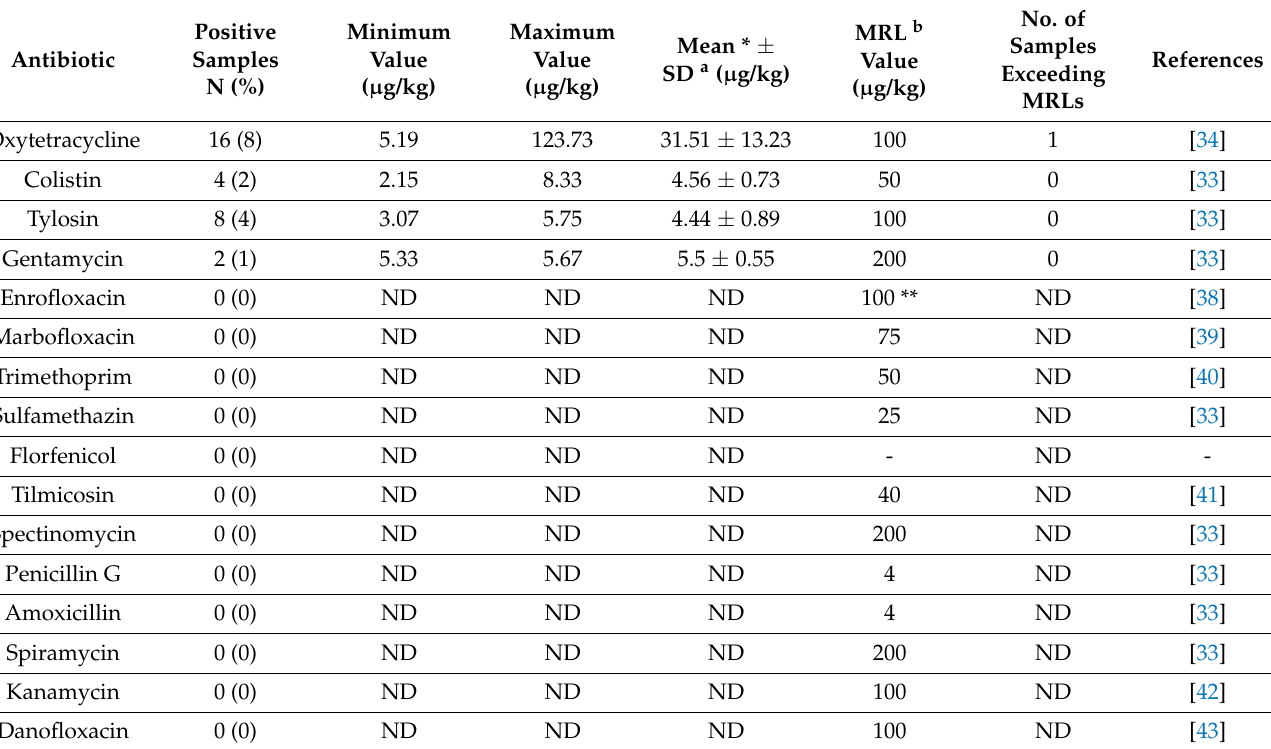
Table 4. Residual levels of the 16 tested antibiotics in collected raw milk samples.